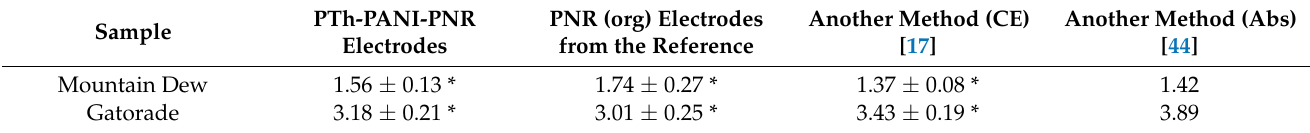
Table 5. Determination of citrate content in g L − 1 in two beverage samples using PNR electrodes by the standard addition method [30] and reference methods (Figure S4)